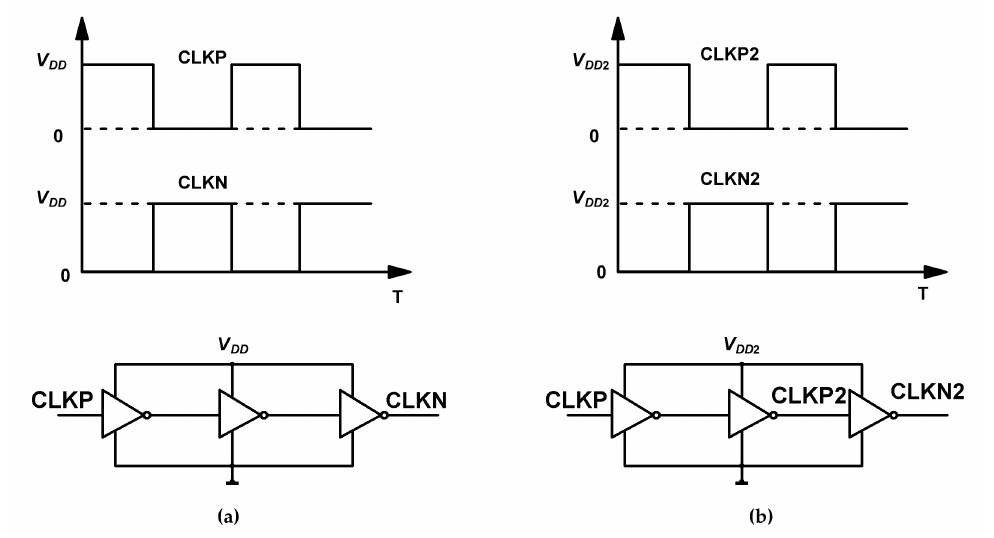
Figure 3. Clocks generation for the two sub-charge pumps: ( a ) clocks for the Dickson charge pump I; and ( b ) clocks for the Dickson charge pump